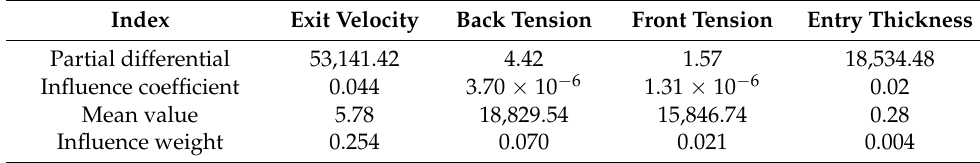
Table 2. An example of the influence coefficient of a course calculation.